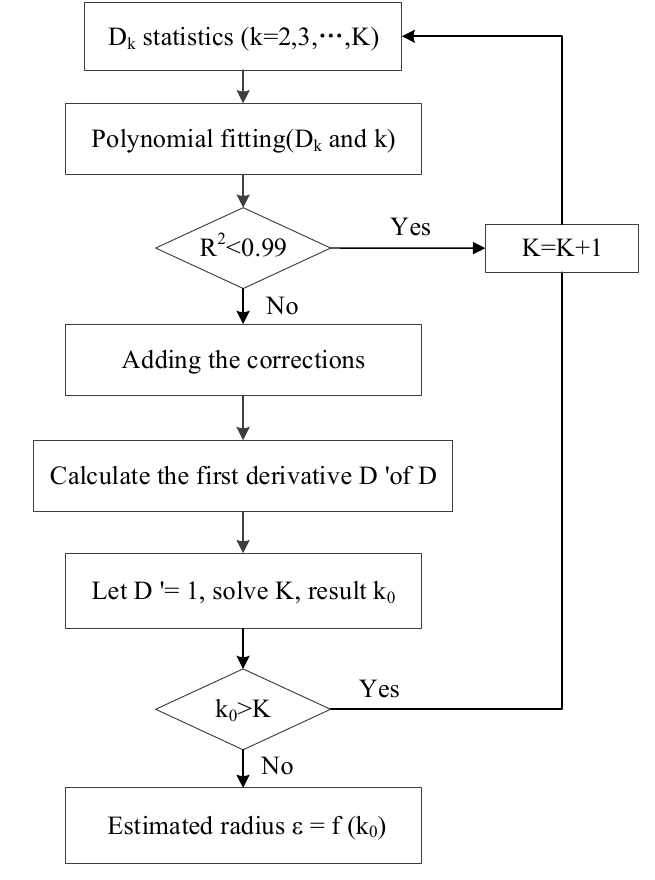
Figure 4. Parameter estimation process.